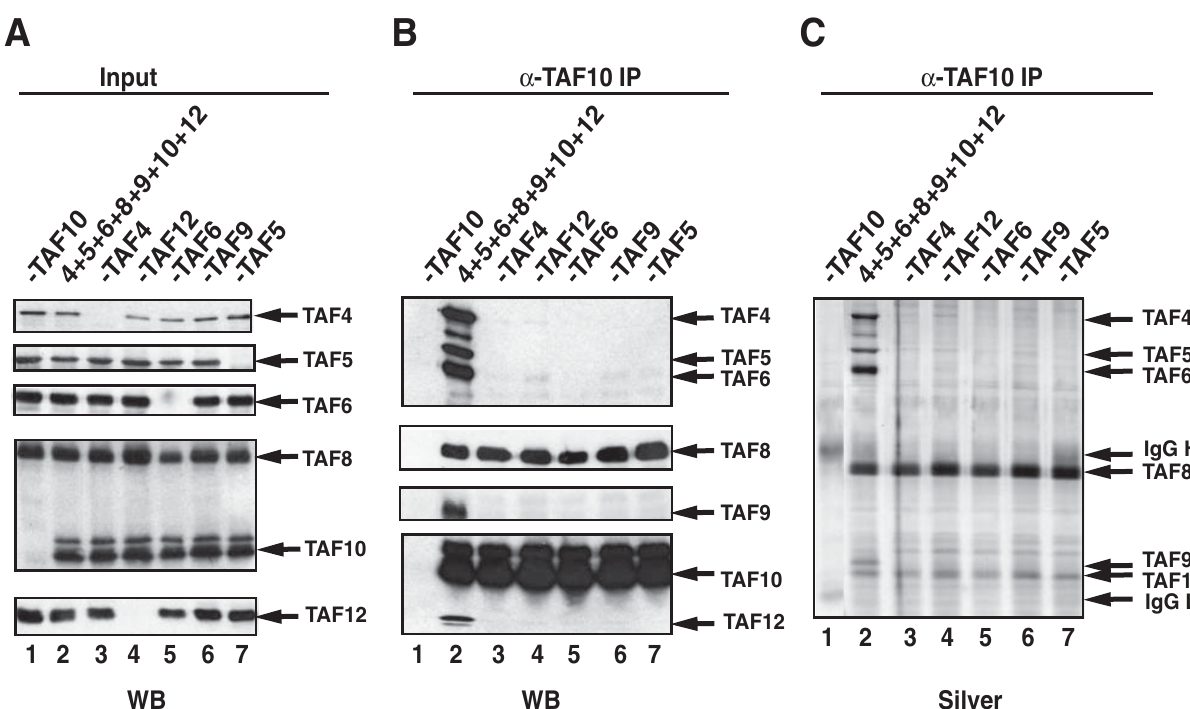
Figure 4. The TAF8-TAF10 HF pair incorporates into a higher order TFIID subcomplex only if another five TAFs are simultaneously present. (A) Either seven TAFs (TAF4, -5, -6, -8, -9, -10 and -12) or only six of them (each time only the omitted TAF is indicated compared to the seven-TAF complex) were coexpressed in Sf9 cells and WCEs made. Protein expression in the WCEs was verified by western blot analysis (WB). Note that in the seven-TAF complex each TAF is indicated with only its corresponding number according to the TAF nomenclature [3]. (B–C) TAF10-containing complexes were purified from the WCEs with an anti-TAF10 mAb (1H8). Bound complexes were eluted by peptide competition and analysed either by western blot (WB) with the indicated antibodies (B) or by silver nitrate staining (Silver)